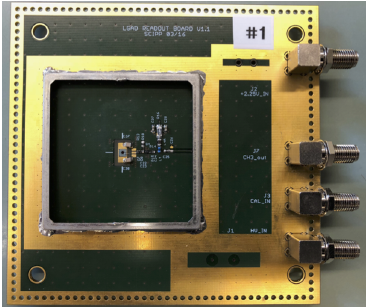
Figure 2. Picture of a sensor bonded to a UCSC pre-amplifier